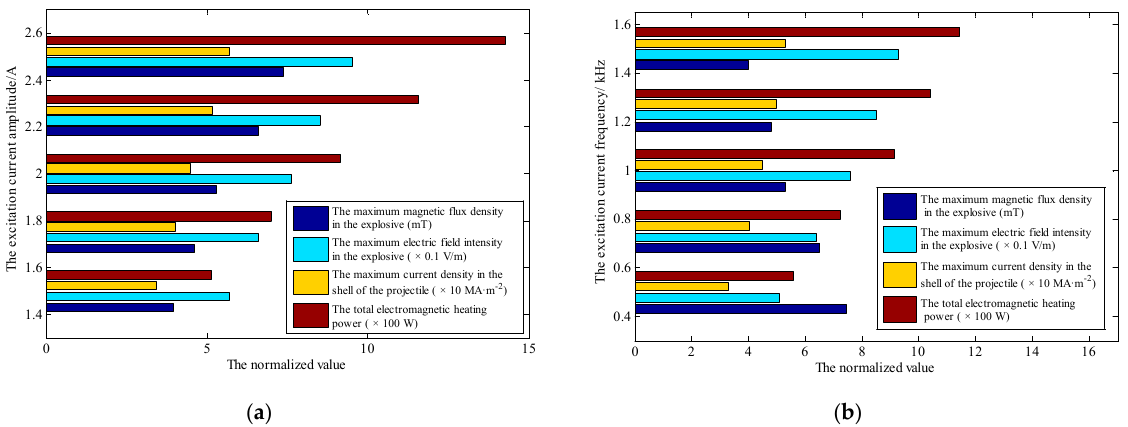
Figure 6. The effect of excitation current characteristics on the electromagnetic field and the electro- magnetic heat. ( a ) Simulation results with different current amplitude. ( b ) Simulation results with different current frequency.